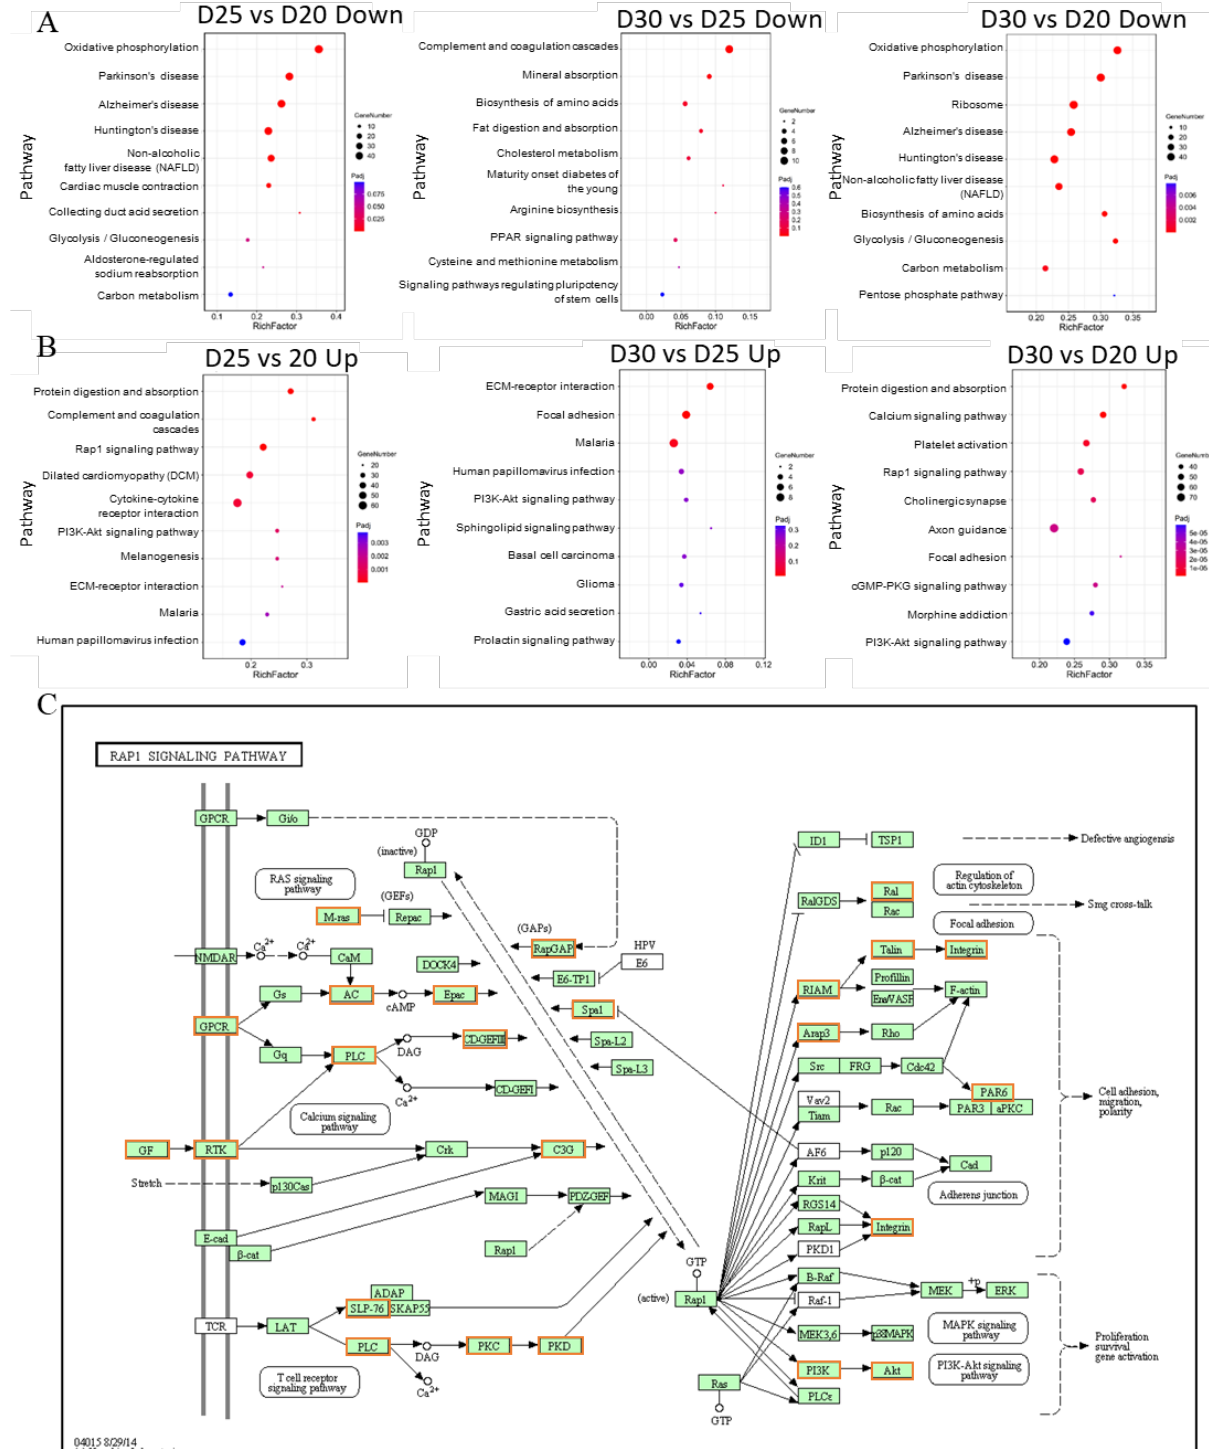
Figure 5. Signaling pathways enrichment of down- and up-regulated DEGs based on KEGG in the pairwise comparison from three-time points of pregnancy. ( A ). KEGG pathway enrichment of down-regulated DEGs in D25 vs. D20, D30 vs. D25, and D30 vs. D20. ( B ). KEGG pathway enrichment of up-regulated DEGs in D25 vs. D20, D30 vs. D25, and D30 vs. D20. ( C ). Distribution of special DEGs in Rap1 pathway signaling pathway. The red frame indicates up-regulated DEGs.